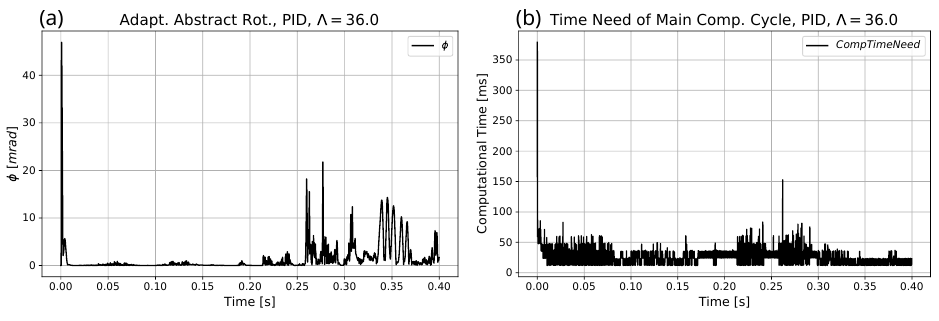
Figure 27. The adaptive abstract rotations ( a ) and the computational time need ( b ) of the main cycle with force limitation ∆ u = 495.0 N or N · m for the increased α min = 0.1.